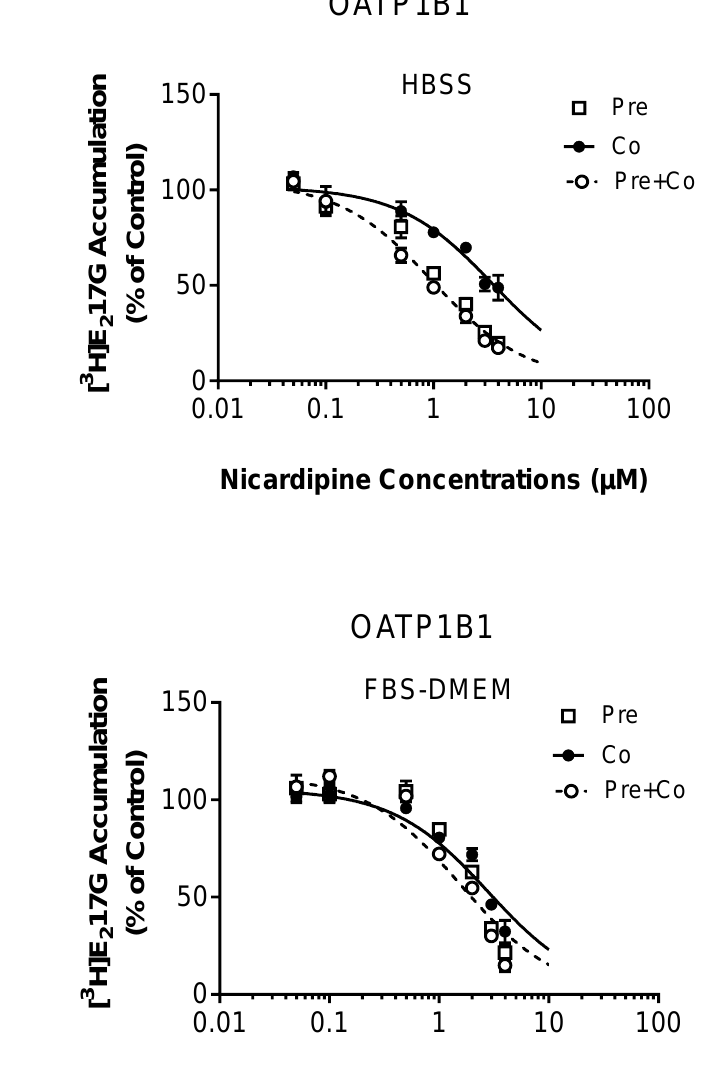
Figure 2. Effects of preincubation with nicardipine in HBSS buffer or FBS-containing medium on the IC 50 value for OATP1B1. OATP1B1-mediated transport of [ 3 H]-E 2 17 β G is expressed as a percentage of vehicle control after 30 min preincubation in nicardipine-containing HBSS buffer ( A ) or FBS–DMEM ( B ) (open squares), coincubation (closed circles) and pre + coincubation (open circles) scenarios with nicardipine (0.05–4 µ M) as the inhibitor are as described in the Materials and Methods. Data represent mean ± SEM ( n = 3 in triplicate). The IC 50 values were determined by fitting dose-response curves to the data using nonlinear regression analysis. Solid (coincubation) and dashed (pre + coincubation) lines represent the fitted lines.